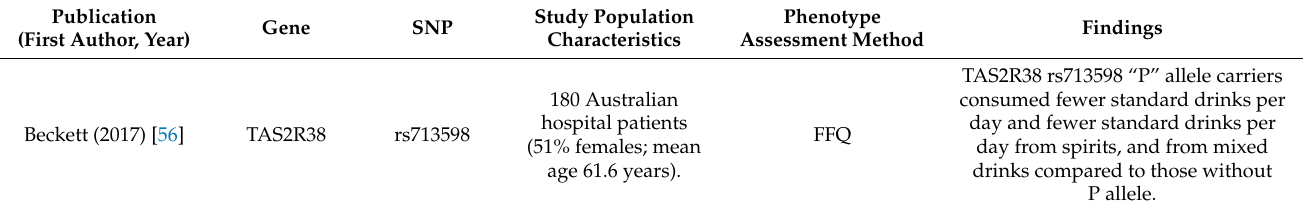
Table 2. Overview of the genetic association studies included in the systematic